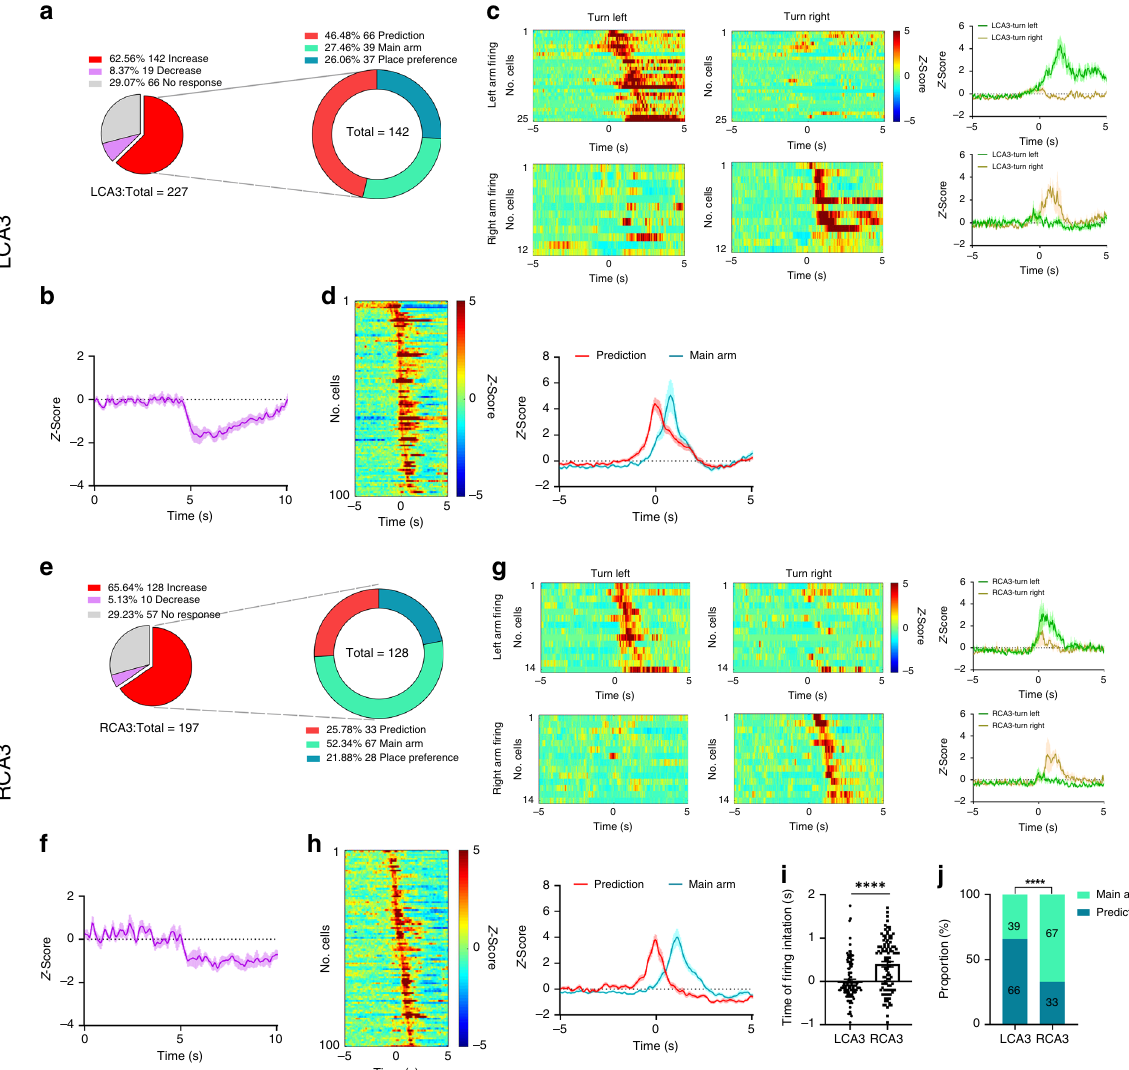
Fig. 2 LCA3 neurons initiate fi ring earlier than RCA3 in the choice phase. a , e The choice phase responsive neuron subpopulations in LCA3 or RCA3. Task-modulated neurons in LCA3 showed a greater proportion of responses when the choice phase initiated. On the right, task-activated neurons were differed into three types: prediction fi ring neurons, main arm fi ring neurons and place preference fi ring neurons. b , f The mean and SEM of Z-score of inhibited cells that are responsive to the choice phase in LCA3 or RCA3. c , g The fi ring heatmap of place preferred (left or right goal arm) neurons in LCA3 or RCA3. Heatmap rows represent the Z-score-transformed average peri-event histogram for individual neurons when mice turn left or right to the goal arm. Plots to the right showed the mean and SEM of Z-score responses for place preference excited cells. d , h Prediction fi ring neurons and main arm fi ring neurons in LCA3 or RCA3. Heatmap rows represent the Z-score-transformed average peri-event histogram for individual neurons. Plots to the right showed the mean and SEM of Z-score responses for prediction fi ring neurons and main arm fi ring cells. i The time of fi ring initiation in each of the prediction and main arm neurons between the LCA3 and RCA3. LCA3 neurons ( n = 105 cells) tended to fi re earlier before RCA3 neurons (n = 100 cells) (unpaired two-tailed Mann – Whitney U test, LCA3 neurons vs. RCA3 neurons, **** P < 0.0001). Data are presented as mean ± SEM. j The proportion of prediction fi ring neurons and main arm fi ring neurons between LCA3 and RCA3. LCA3 showed higher proportion of prediction fi ring neurons than RCA3 (two-sided Pearson ′ s chi-squared test, **** P < 0.0001). Source data are provided as a Source Data fi